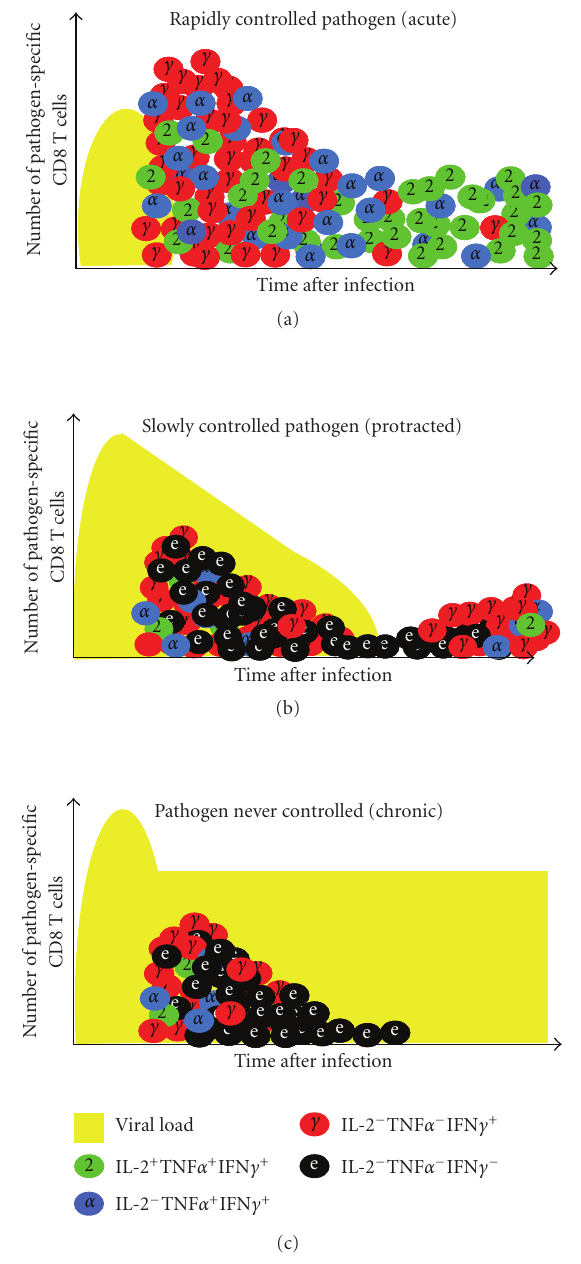
Figure 1: Pathogen-specific T cell responses to acute and chronic infections vary in magnitude and functional attributes. (a) Acute infections elicit a large CD8 T cell response, and after resolution of the infection the memory pool is typically composed of polyfunctional T cells capable of coproducing IFN γ , TNF α , and IL- 2 (green circles) or IFN γ and TNF α (blue circles). (b) Protracted infections are associated with weaker responses and reductions in the functional quality of the responding T cells, such as the emergence of CD8 T cells which only produce IFN γ (red circles) as well as the development of exhausted cells that are